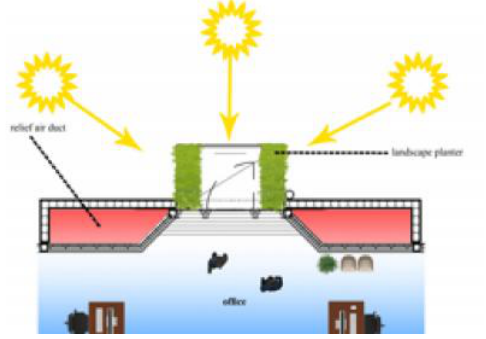
Fig. 3: functional diagram of terrace and office space, and channeling of hot air through air